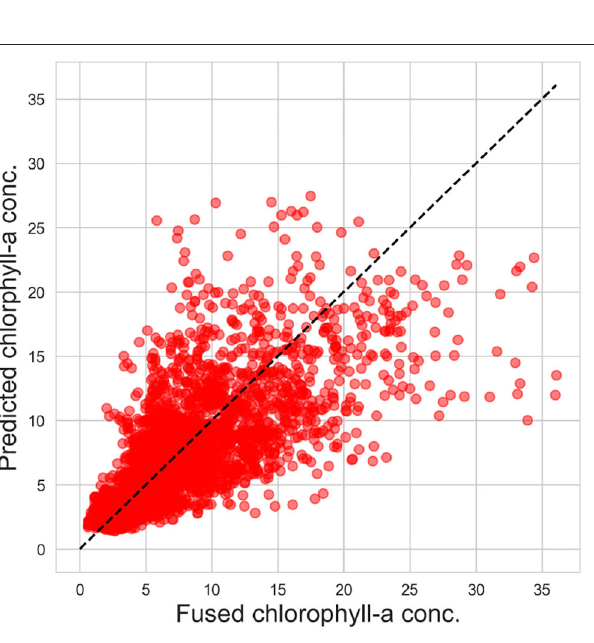
FIGURE 10 | Scatter plot of predicted chlorophyll-a concentration against fused observations. Model forecast between 2010 and 2018 with N = 3,287 data